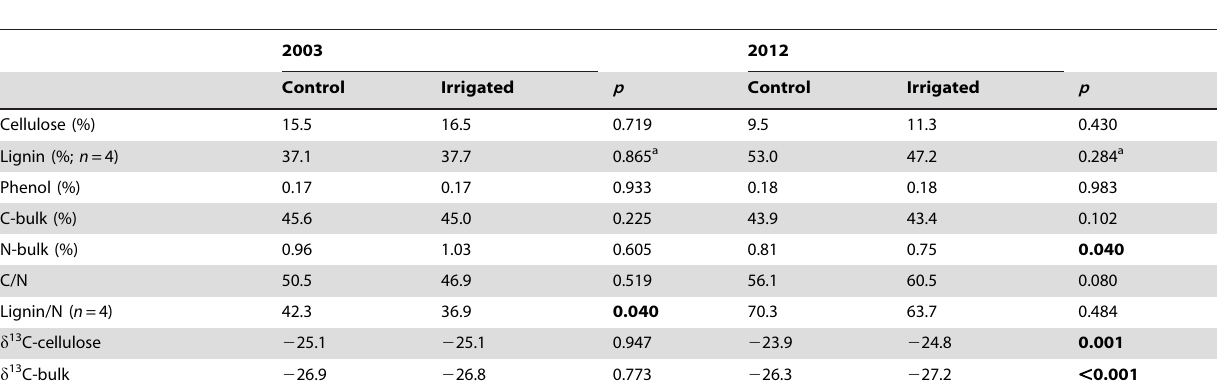
Table 4. Chemical properties of Pinus sylvestris fine roots before and after nine years of